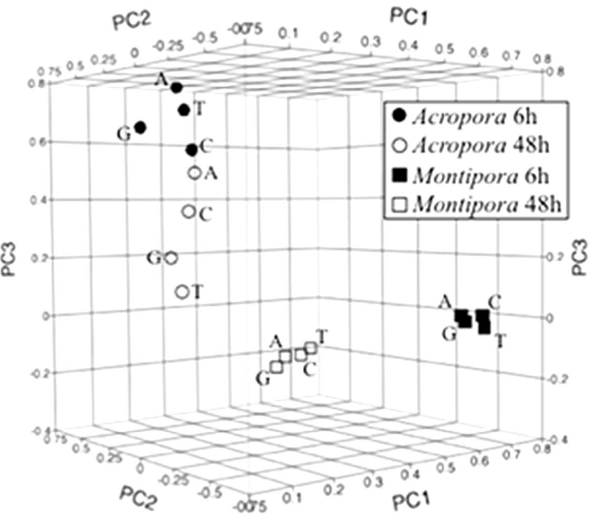
Fig. 4. Multivariate grouping of coral exposure treatments using principle components analysis based on 850 differentially expressed Acropora millepora and Montipora digitata genes (both coral and Symbiodinium ) relative to controls. All genes included in this analysis are in S2 Table. A 5 Amphiroa crassa , C 5 Chlorodesmis fastigiata , G 5 Galaxaura filamentosa and T 5 Turbinaria conoides .